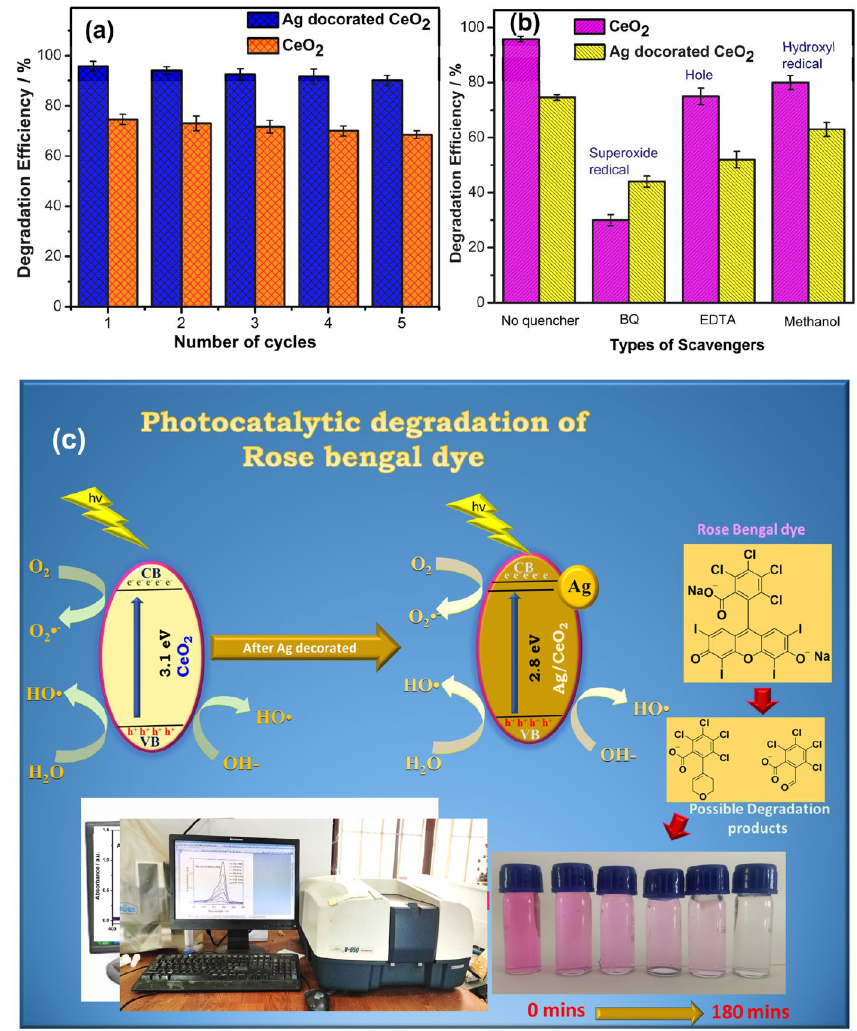
Figure 8. ( a ) Stability test of the CeO 2 and Ag decorated CeO 2 catalyst after 5 cycles. ( b ) Scavenger studies of CeO 2 and Ag decorated CeO 2 catalyst. ( c ) Schematic diagram illustrating the mechanism of charge separation and photocatalytic activity of photocatalyst under the sunlight